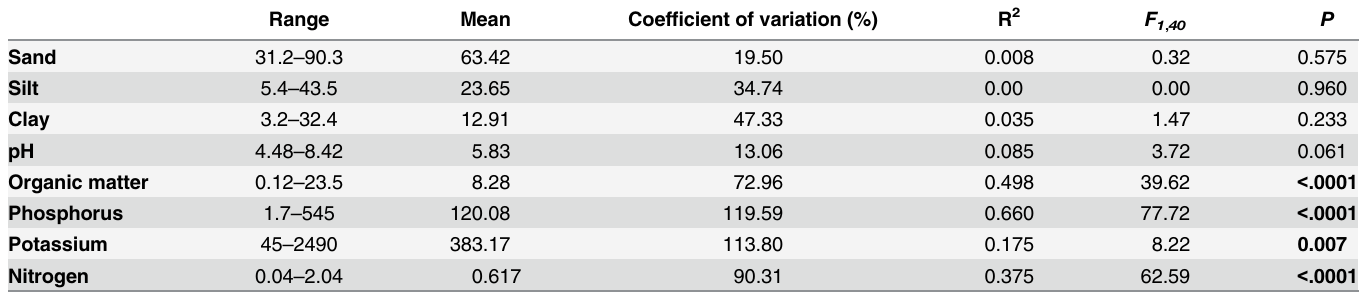
Table 1. Variation in chemical and physical characteristics of soil samples considered in this study and corresponding univariate tests using GLM procedure for differences between topsoils of owl nests vs . control